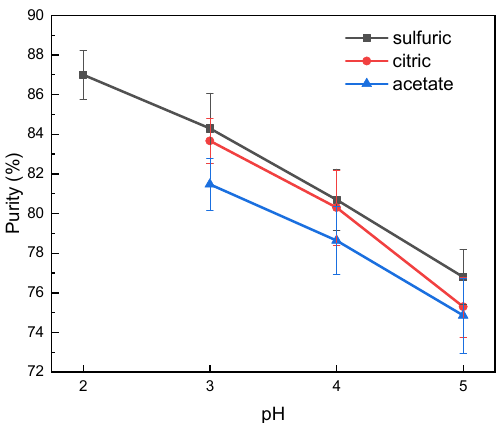
Figure 2. The purity of isolated lignin in various pH and acid types.